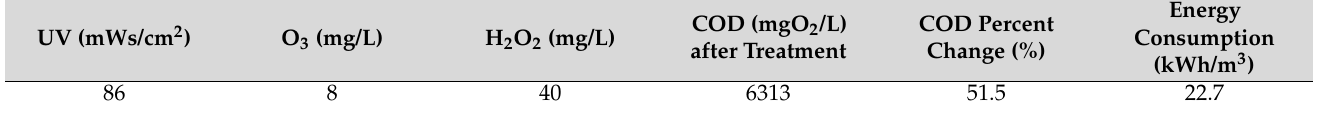
Table 5. The optimized values defined for AOP.